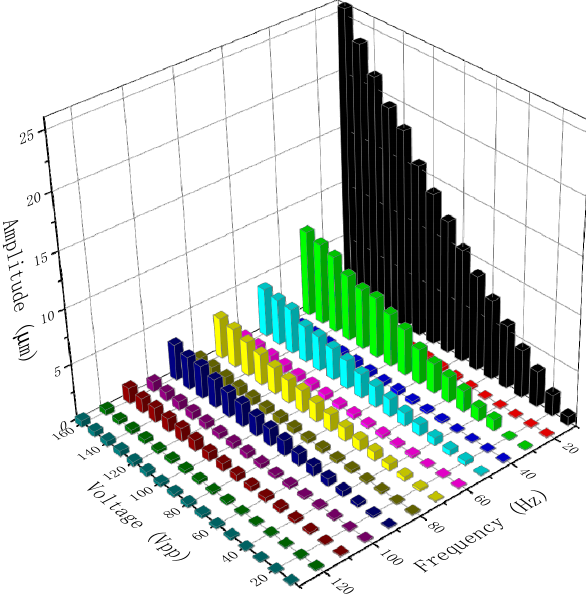
Figure 6. The amplitude-voltage-frequency relationships of the PZT vibrator.